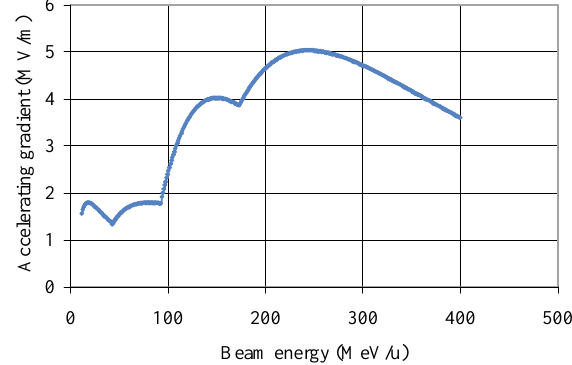
FIG. 2. (Color) Effective accelerating gradient of the driver linac downstream of the first